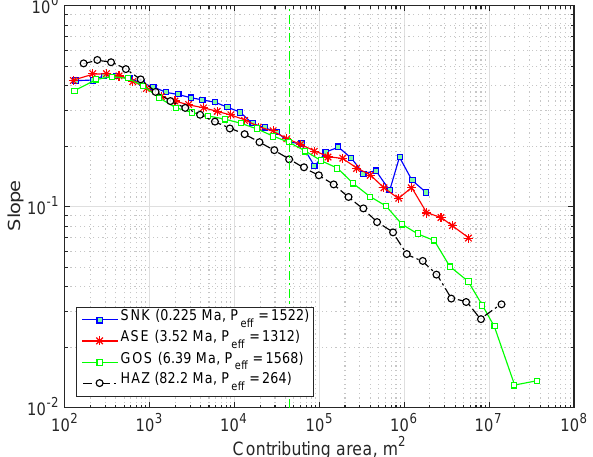
Figure 11. Mean slope–area relationship for the catchments with tectonic uplift of 750m in the Quaternary. Vertical dashed lines rep- resent visually determined larger inflection points for TMG (2 . 1 × 10 6 m 2 , red), NAR (4 . 5 × 10 5 m 2 , light blue), YUD (4 . 2 × 10 4 m 2 , deep blue), and ISB (2 . 9 × 10 6 m 2 , green), respectively.